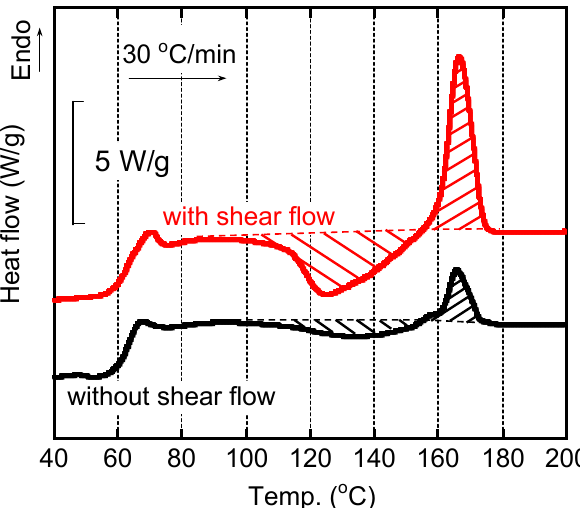
Figure 4. DSC heating curves of the quenched films with/without shear history. The heating rate was 30 °C/min.